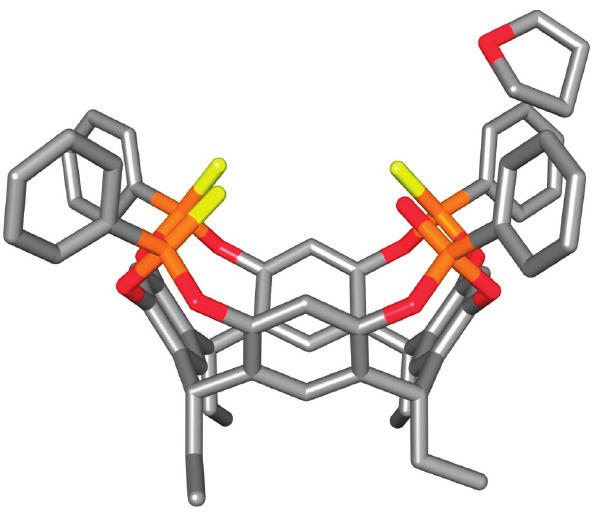
Figure 2. Molecular structure of 1POi3PSiii[C S, yellow; O, red; C, grey. Hydrogen atoms have been omitted for clarity. The two